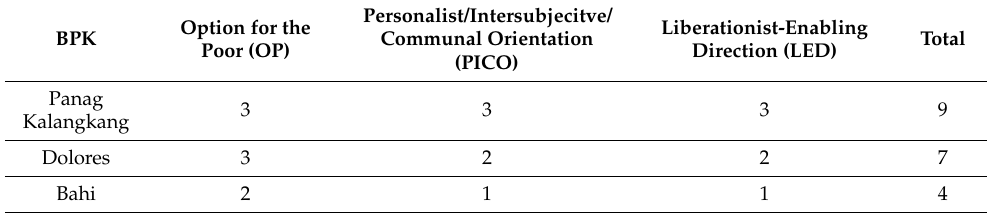
Table 3. Evaluative Scores of Three BECs relative to the salient features of Jesus’ compassion